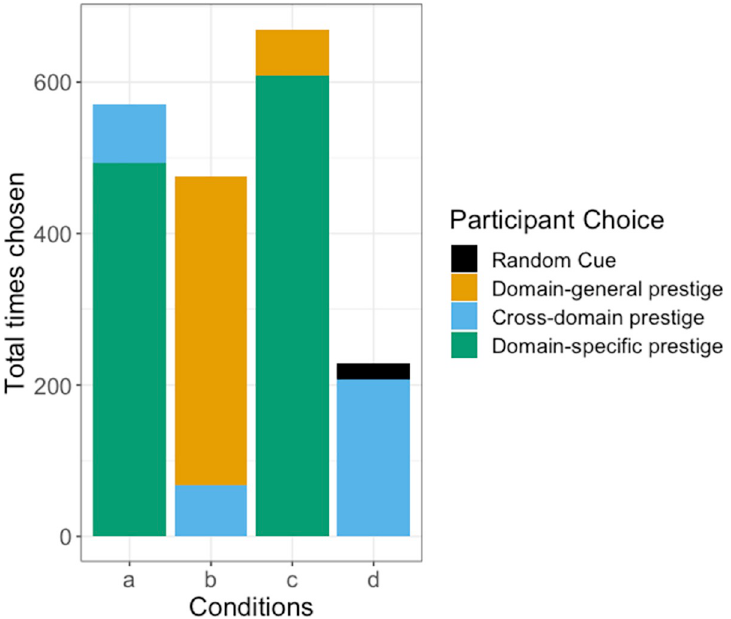
Fig 2. Raw counts of the information chosen when participants chose to copy someone else’s answer in Round 2. Total possible copying instances for each condition in Round 2 were: Condition A = 3240, Condition B = 3437, Condition C = 3377, Condition D = 3416.